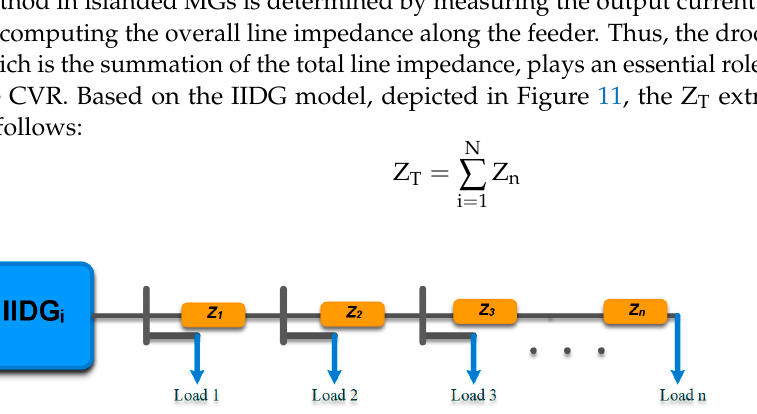
Figure 11. Sample IIDG connected to the loads through various line